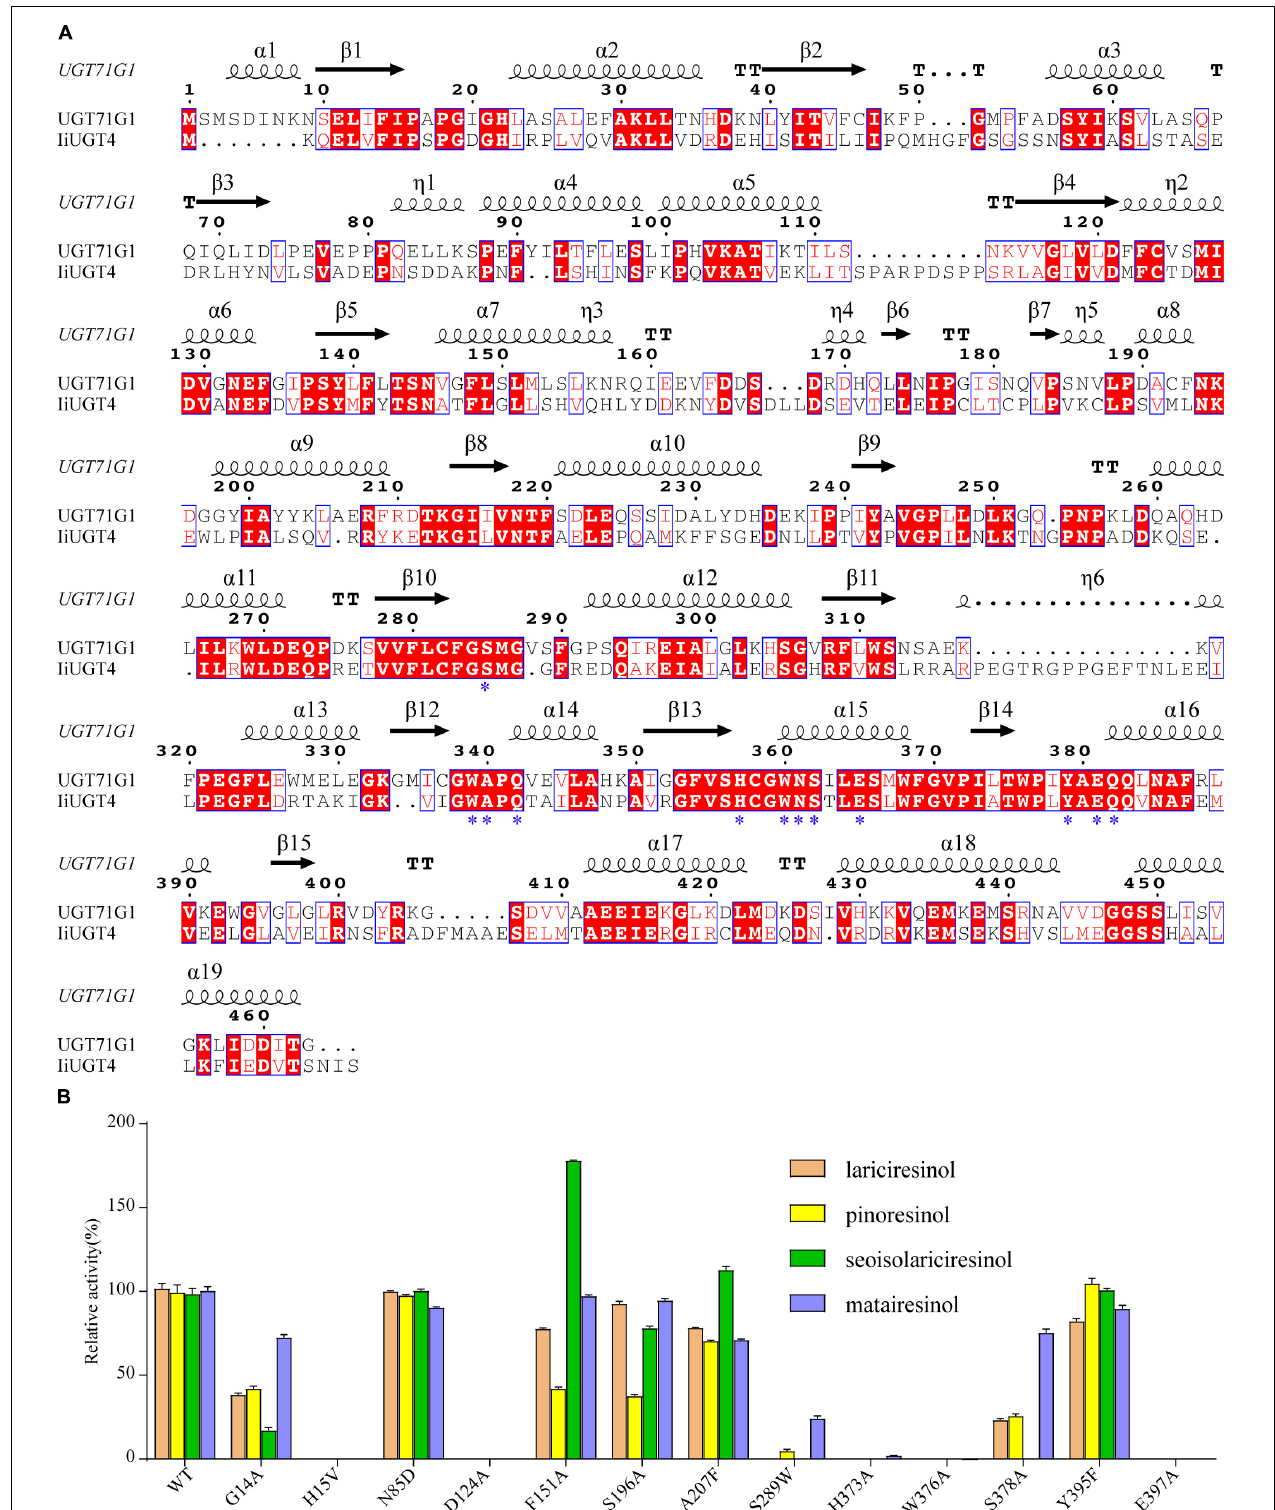
FIGURE 8 | Structure-based sequence alignment and site-directed mutagenesis revealed the essential residues of IiUGT4. (A) Structure-based sequence alignment of IiUGT4 using UGT76G1 structure as a reference. α -helices was presented as large squiggles, β -strands as arrows, and strict β -turns as TT letters. The conserved residues interacting with the substrate were labeled with star symbols. (B) site-directed mutagenesis to identification of the essential residues of IiUGT4.